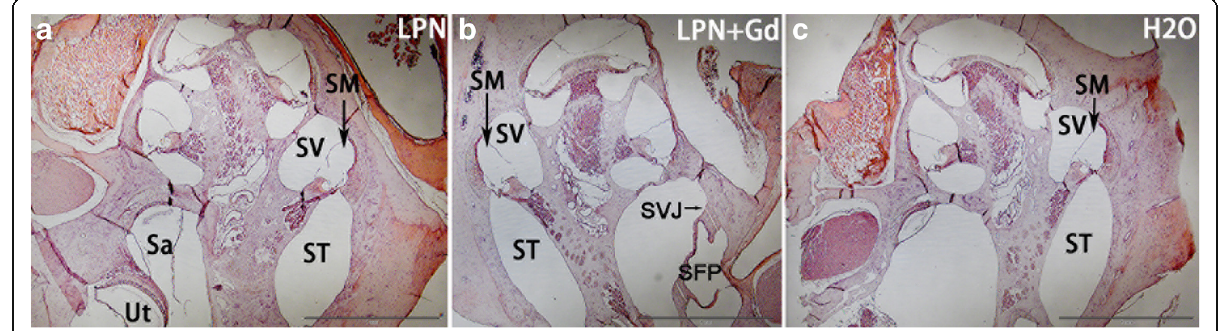
Fig. 4 Hematoxylin-eosin staining of rat cochleae exposed to liposome nanocarriers. There was no inflammatory infiltration in the cochlea received administrations of LPN ( a ), LPN+Gd ( b ), and H2O ( c ). Circled area indicated selection of region of interests for intensity measurements ( a ). LPN empty liposome nanocarrier, LPN +Gd Gd-DOTA-containing LPN. Sa saccule, SFP stapes footplate, SVJ stapediovestibular joint, SM scala media, ST scala tympani, SV scala vestibuli, Ut utricule. Scale bar =1